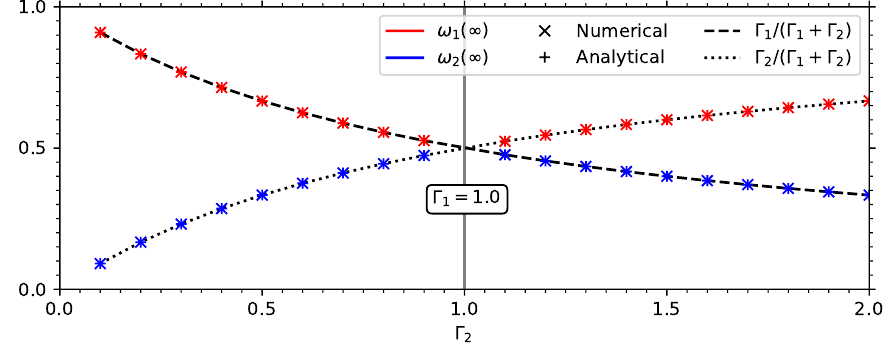
Figure 16: Comparison of the analytical results (113) with numerical results of ω ( ∞ ) and ω ( ∞ ) obtained by integrating the flow equations numerically. The 1 2 data points match up to numerical precision and lie on the expected lines Γ / ( Γ + Γ ) and Γ 2 1 2